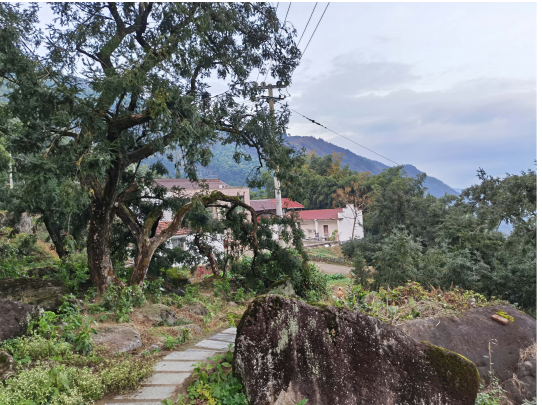
Figure 4. The landscape consisting of Chinese Torreya trees and hamlets in Baiyankeng village (photographed by a village helper in November